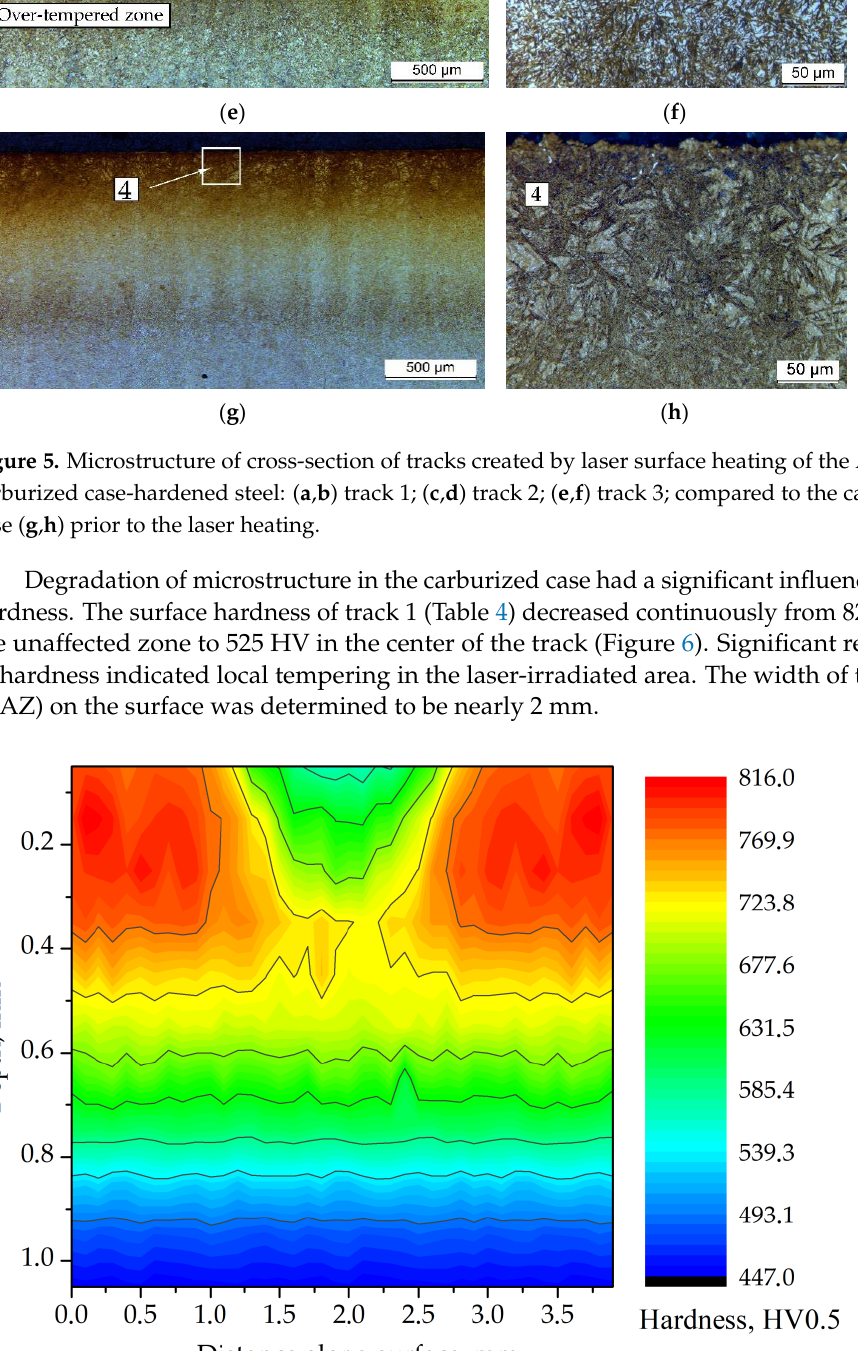
Figure 6. Hardness distribution map for the cross-section of track 1. Processing parameters: laser beam power of 80 W; traverse speed of 250 mm·min −1 .